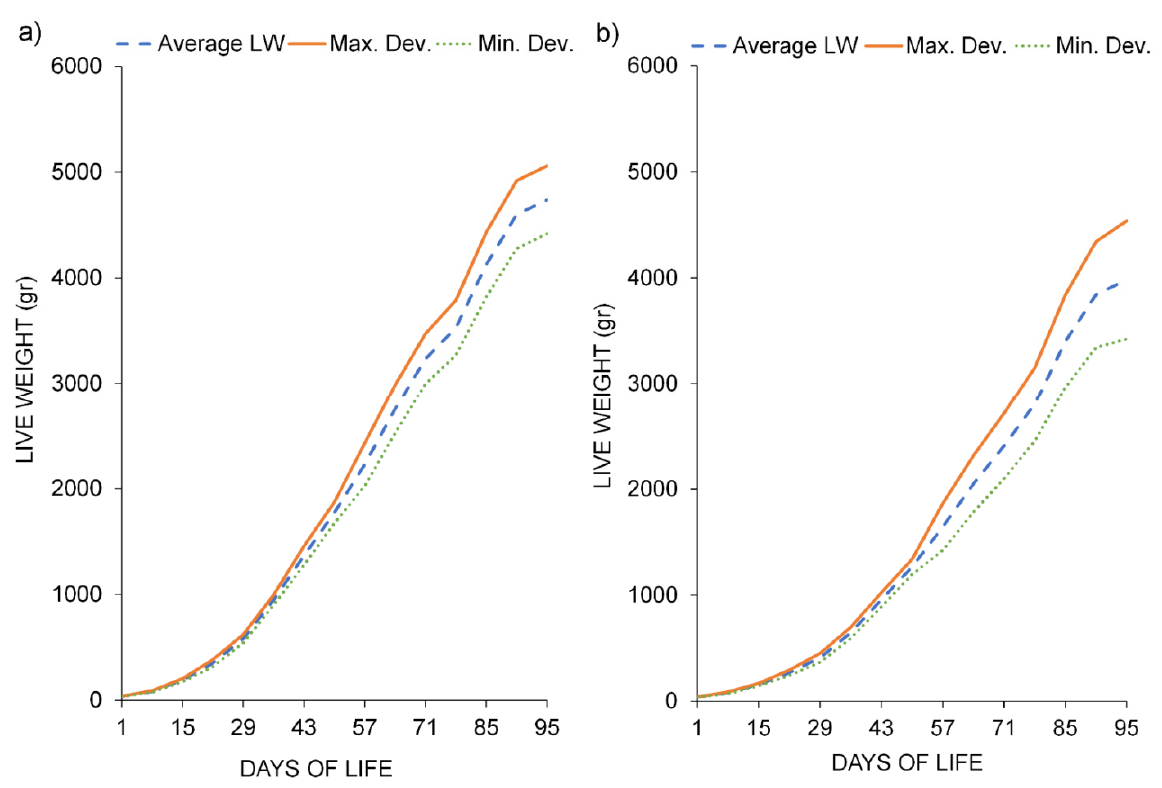
Figure 1. LW curves for the two studied groups (C, Control group and TM, Tenebrio group) throughout the growing period (95 days). ( a ) Group C and ( b ) group TM. LW: live weight, Max Dev.: maximum live weight deviation and Min. Dev.: minimum live weight deviation.